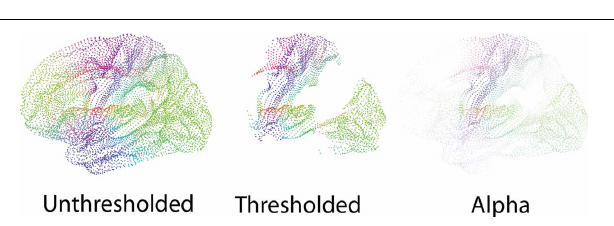
FIGURE 8 | Unthresholded (Left), thresholded (Middle) and transparent (Right) point glyphs. Thresholding the glyphs leads to characteristic shapes, which also work well when minimized. Drawing glyphs with alpha blending makes it possible to perceive different connectivity